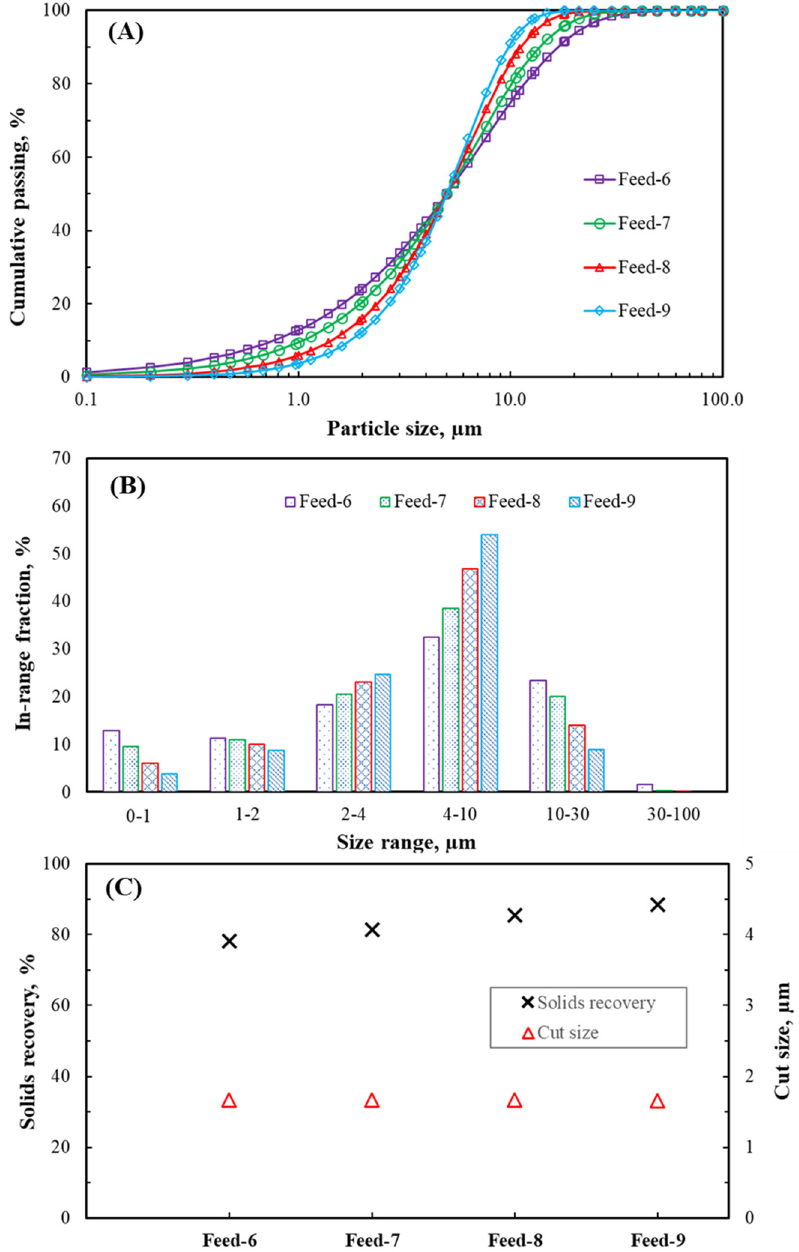
Figure 13. ( A ) The cumulative curve of Feed-6 to Feed-9, ( B ) in-range fraction histogram of Feed-6 to Feed-9 and ( C ) solids recoveries and cut sizes of the SBC for Feed-6 to Feed-9.